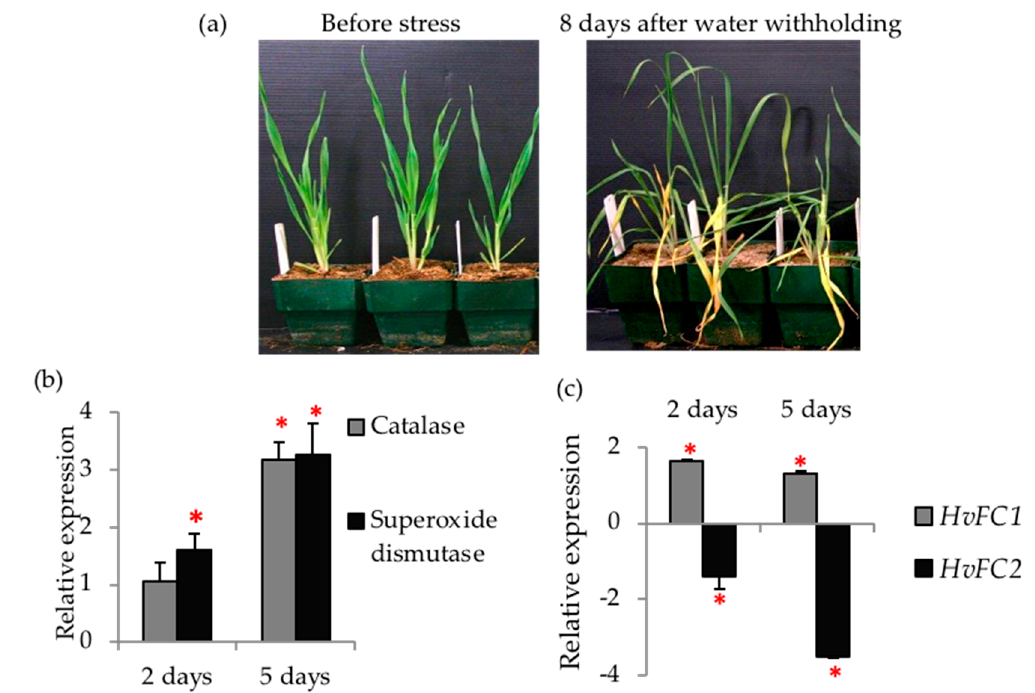
Figure 8. Transcript abundance of ROS detoxification markers (Cat and SOD) and HvFC s in control plants upon drought stress. ( a ) Phenotypes of control plants before stress and after exposure to drought stress. ( b ) Expression of Cat and Sod and, ( c ) HvFC1 and HvFC2 in drought-treated plants, relative to the well-watered plants. The data are shown as mean ± standard error (SE) of 3 different plants. Asterisks indicate a statistically significant expression difference relative to the well-watered plants, at * p < 0.05, based on one-way ANOVA.